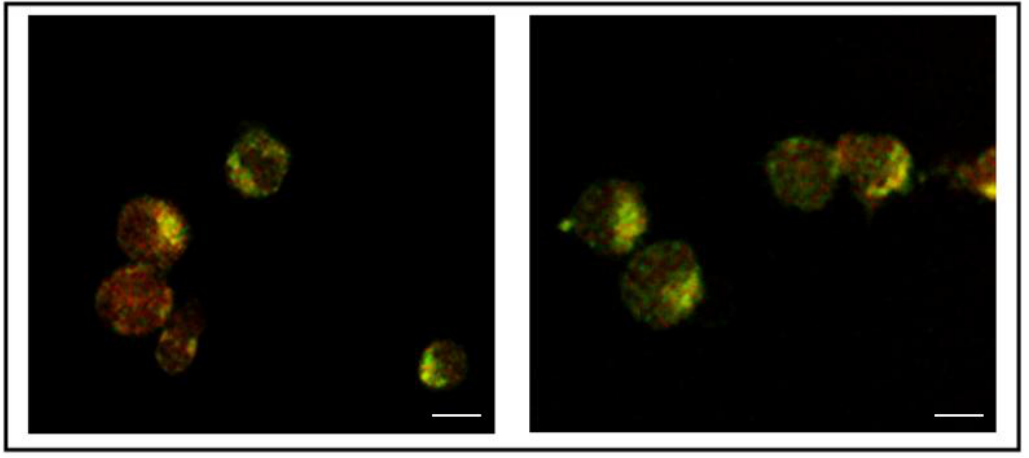
Figure 3. Internalization of CD7-SAP ITx revealed by co-localization with C6-NBD- KDEL ceramide and immuno-staining with anti-KDEL and TRITC-anti mouse. Cells incubated with CD7-SAP were stained with the vital Golgi fluorescent marker NBD ceramide KDEL (Green staining) and after fixation with the anti-KDEL monoclonal antibody (Red staining). The two panels represent merged images of independent cells obtained by confocal microscopy. C6-NBD ceramide was added 10’ before the incubation together with the ITx (30’ time) followed by fixation of the cells and immune-localization. Please note that green or red fluorescence alone can be seen together with intensely fluorescent perinuclear structures which are due to yellow overlapping fluorescences likely representing the Golgi apparatus. The white bar represents 10 